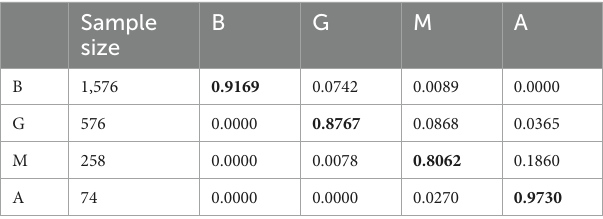
TABLE 6 Markov transition probability matrix ( k = 4